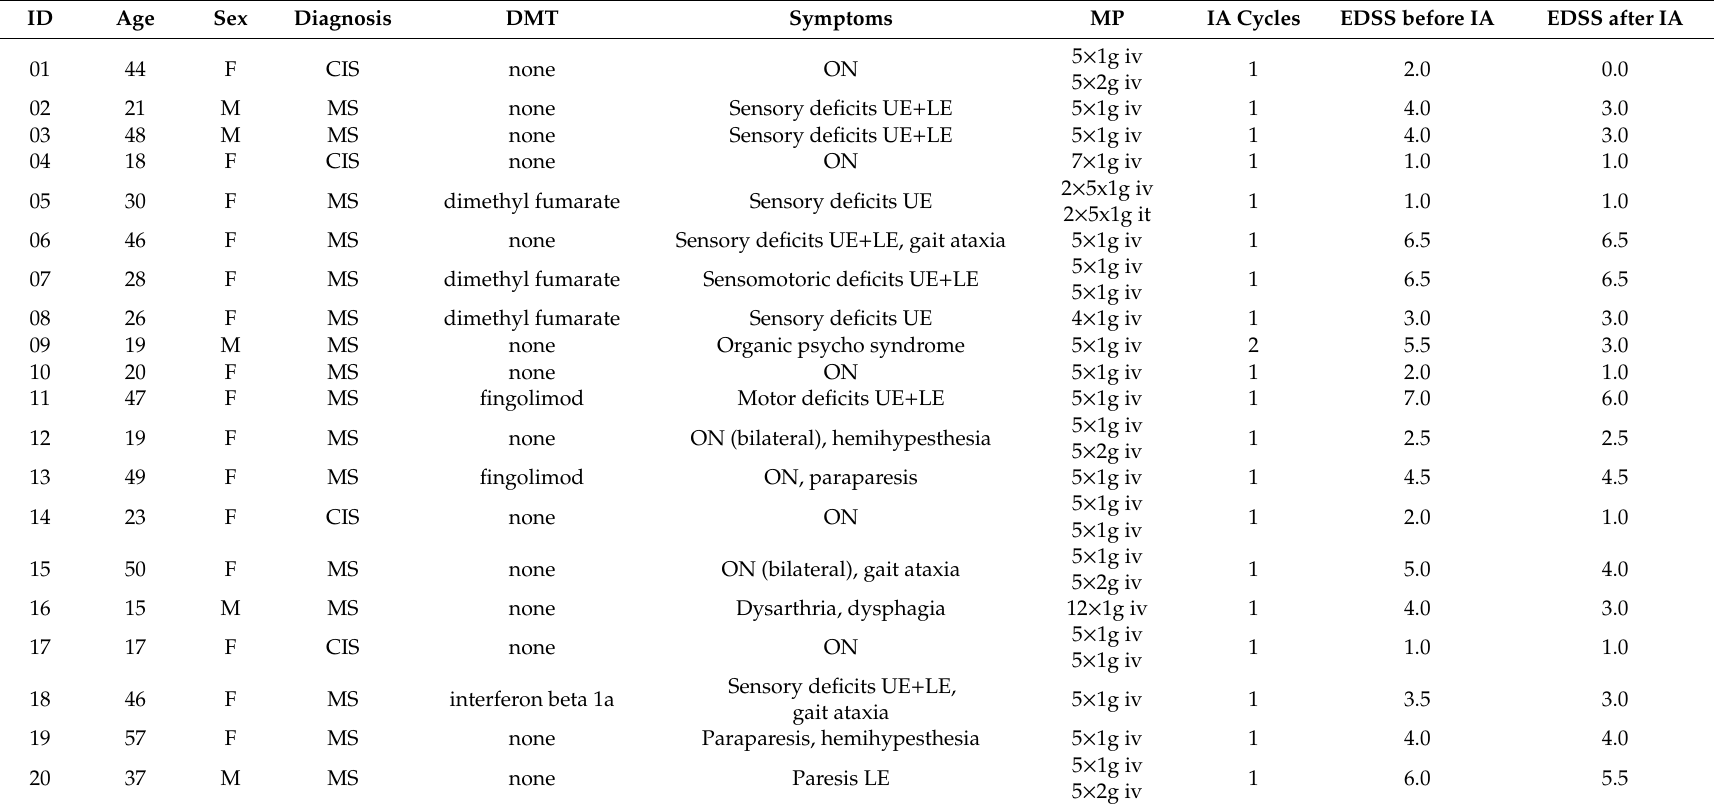
Table A3. Baseline characteristics and response to IA treatment of the MS